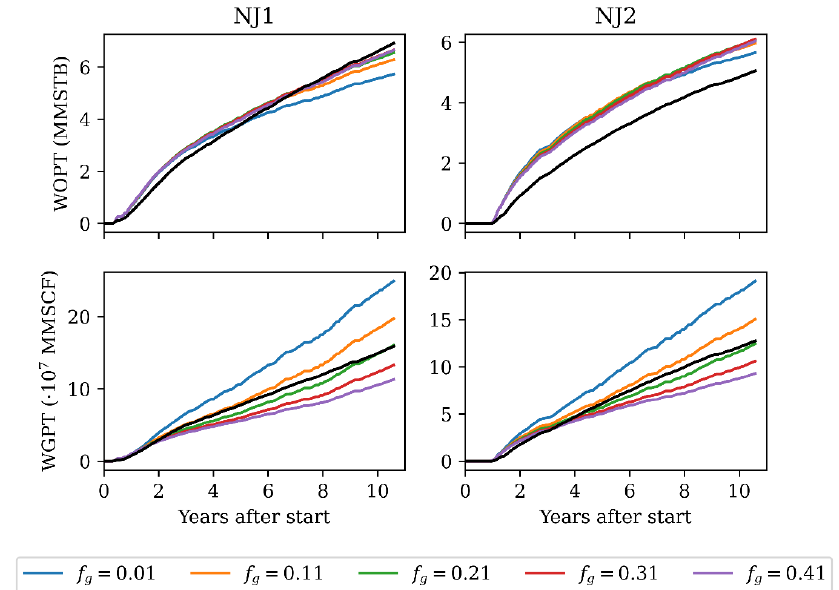
Figure 5. The production volumes for the North Jens model, corresponding to the different relative permeabilities in Figure 4. Black lines denote historical data.